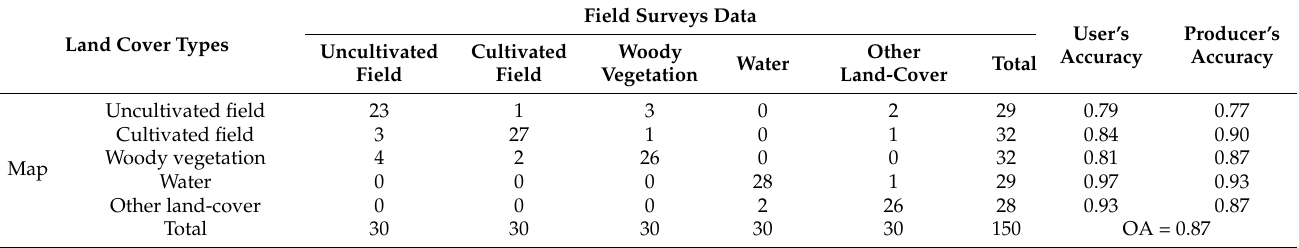
Table 2. Accuracy assessment of annual land cover classification model based on field surveys data.